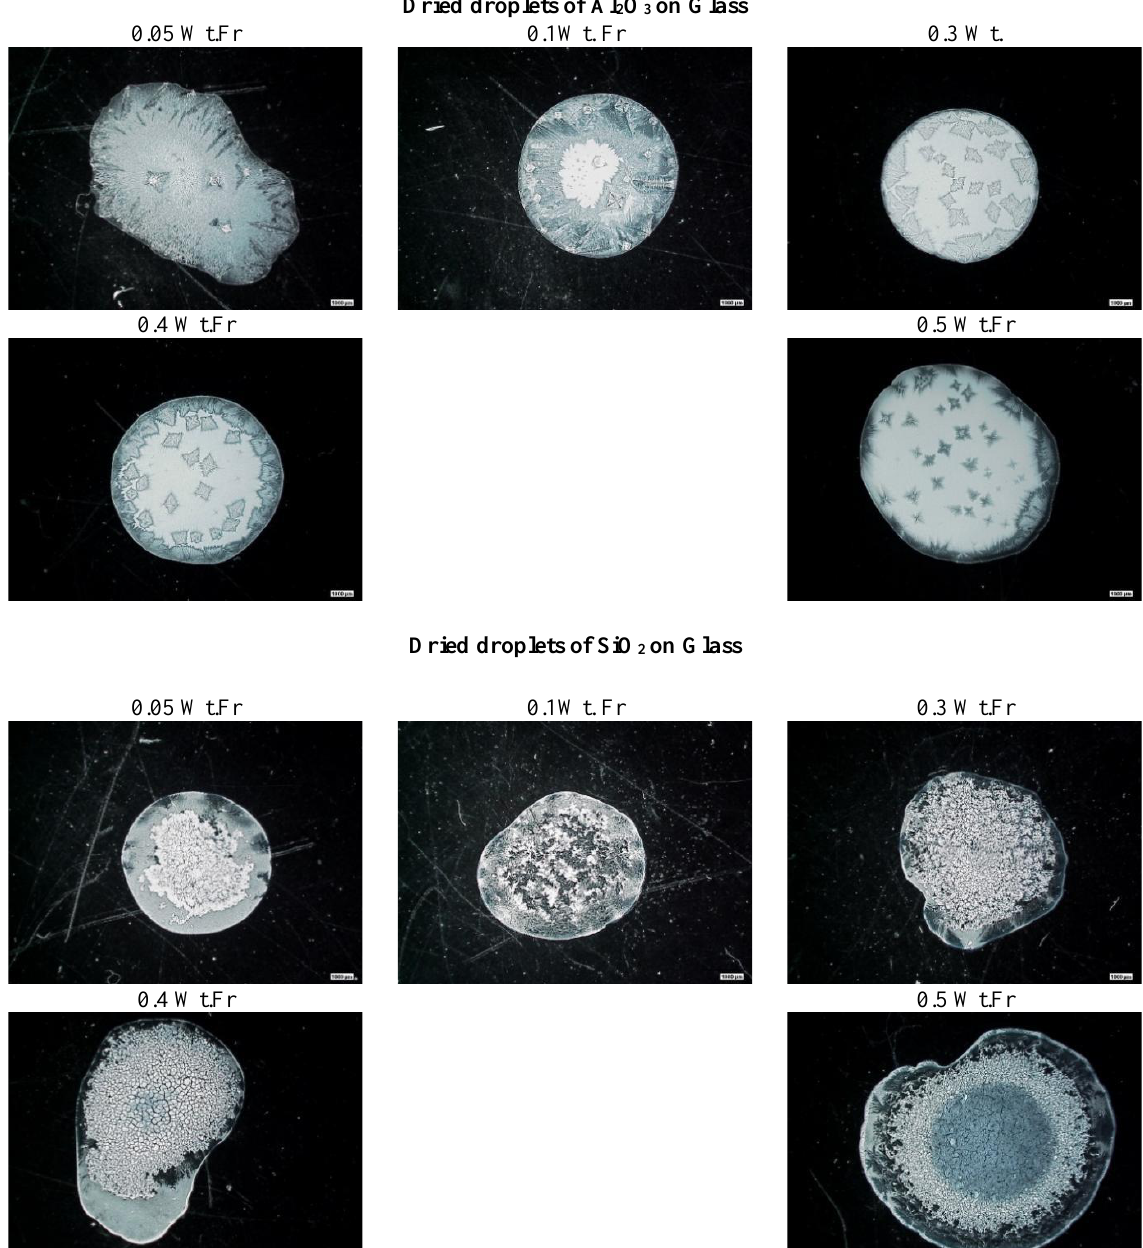
Figure 11—Dried droplets of Al concentration and some at the highest concentration. None appear in SiO and this feature in not clear in silica. We see coffee stain behavior in all. Small horizontal bar in every frame is 1000 µm indicating larger areas involved due to drop